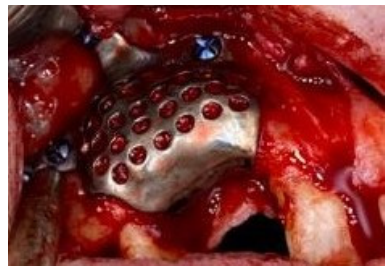
Figure 7. Intraoperative image: the precise application of the titanium mesh (0.5 mm thick) fixed by the screws protects the added bone-mixed particles.